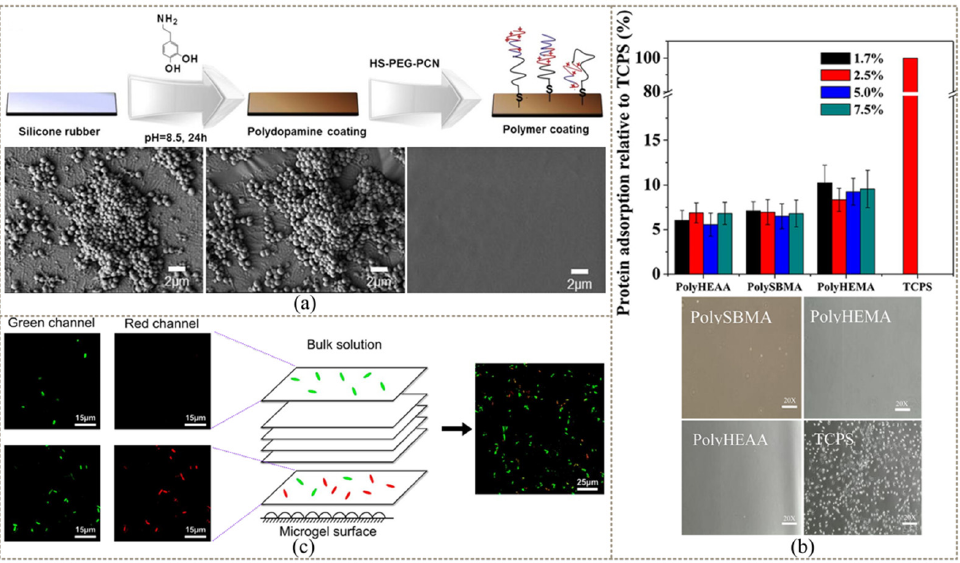
Figure 9. Bactericidal and bacteriostatic effects of anti-adhesion coatings: ( a ) preparation process and antibacterial effect of coating [135]; ( b ) anti-adhesion effect on proteins [138]; ( c ) confocal laser scanning microscope imaging and diagram of Escherichia coli adhesion [143].